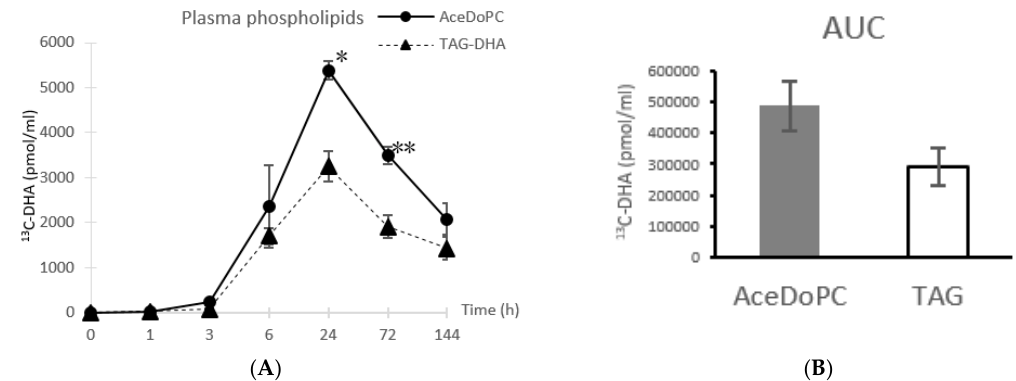
Figure 1. 13 C-DHA in plasma phospholipids from AceDoPC compared to TAG-DHA after 50 mg DHA intake in both esterified forms, at different times post-intake ( A ). Results are expressed in pmol of 13 C-DHA per mL of plasma, presented as means ± SEM from three values. ( B ) represents area under curves (AUC) from Figure 1A. Stars indicate significant differences within each time, according to the student t test.